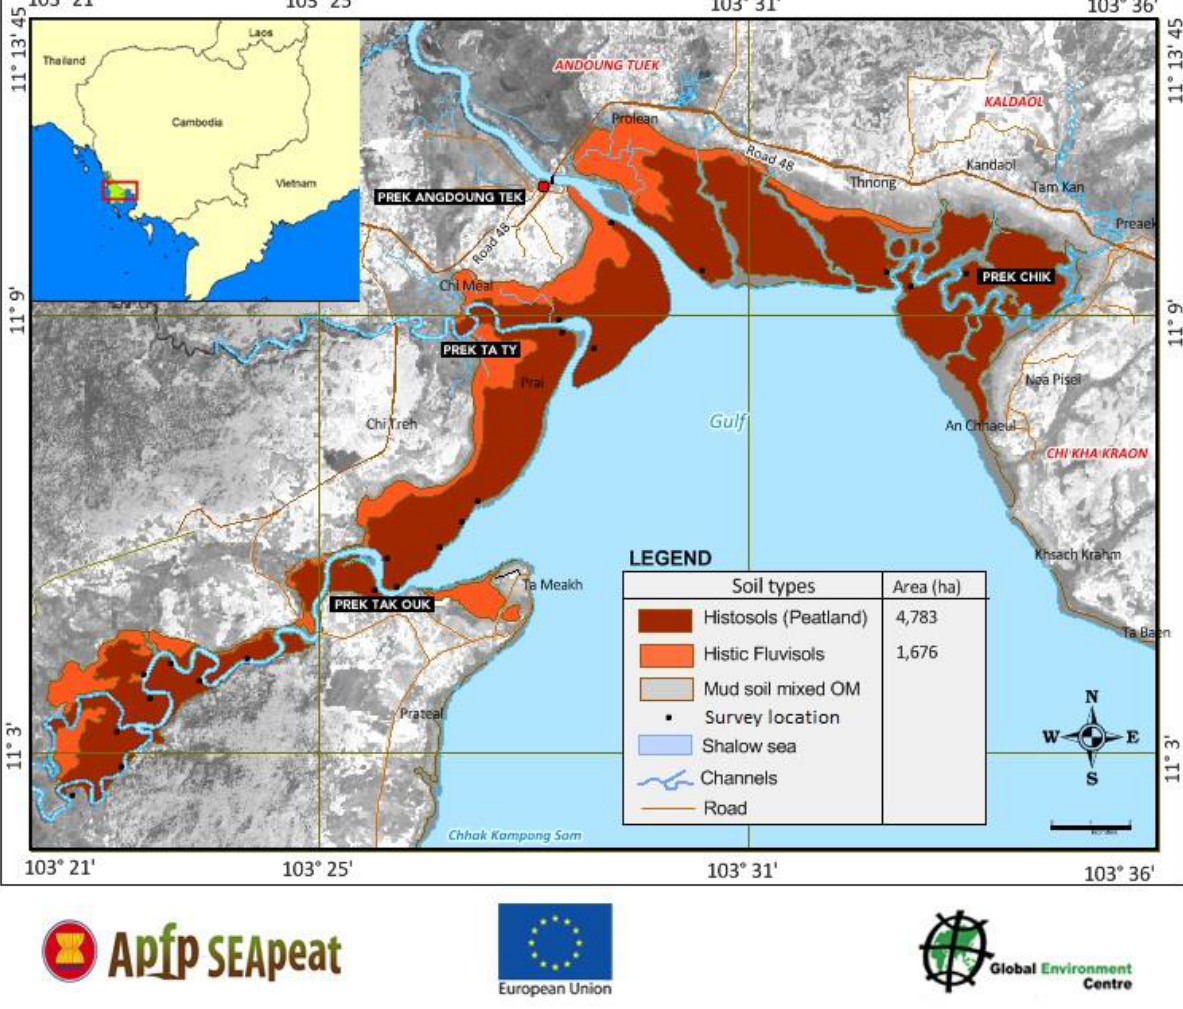
Figure 1: Peatland distribution in Botum Sakor, Koh Kong Province,